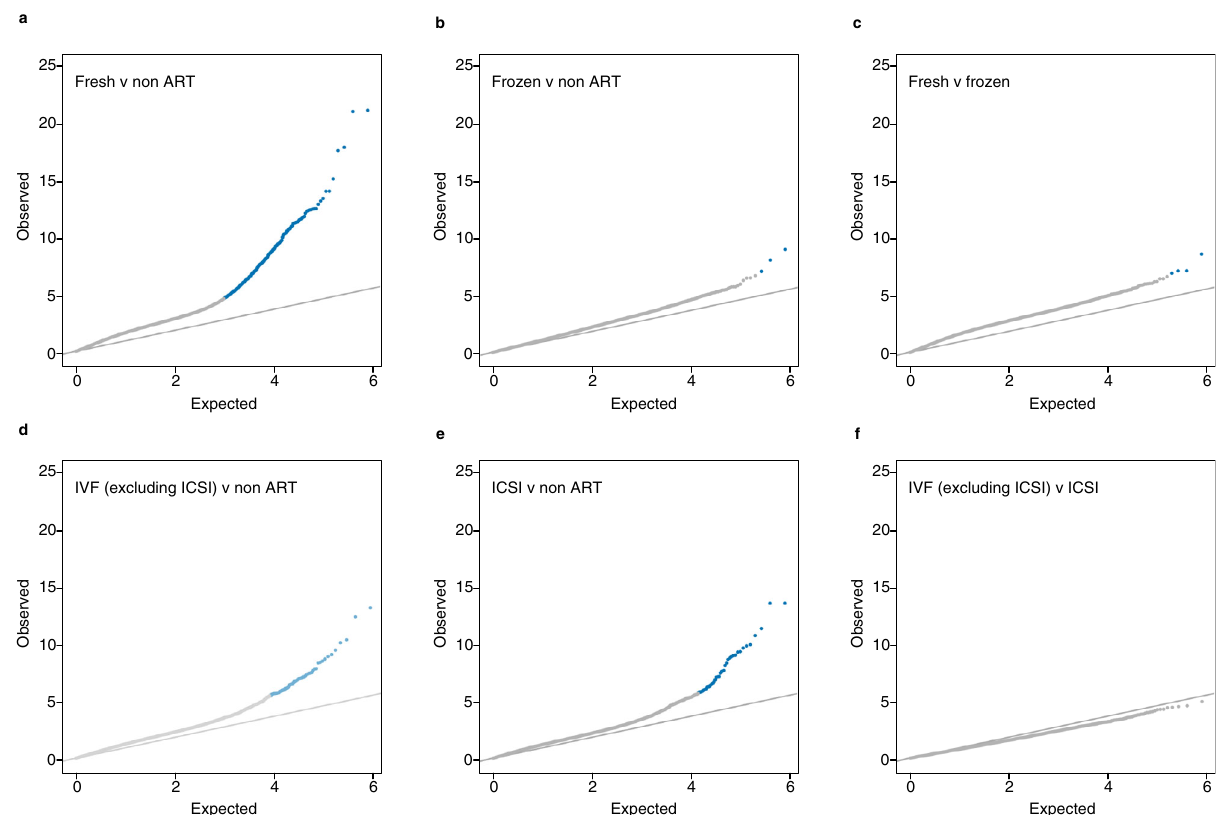
Fig. 5 Quantile-Quantile plots of observed versus expected − log 10 P values for methylation differences with different ART procedures. The observed − log P values on the y-axis (calculated from t statistics) were derived from two-sided t tests comparing the DNA methylation levels between: a ART 10 conceived newborns using fresh embryo transfer ( n = 764) and naturally conceived newborns ( n = 983), b ART conceived newborns using frozen embryo transfer ( n = 126) and naturally conceived newborns ( n = 983), c ART conceived newborns using frozen embryo transfer ( n = 126) and fresh embryo transfer ( n = 764), d ART conceived newborns using in vitro fertilization (IVF) without intracytoplasmic sperm injection (ICSI) ( n = 511) and naturally conceived newborns (n = 983), e ART conceived newborns using IVF with ICSI ( n = 359) and naturally conceived newborns ( n = 983), f ART conceived newborns using IVF with ICSI ( n = 359) and ART conceived newborns using IVF without ICSI ( n = 511). The adjusting variables were maternal age, maternal smoking, maternal body mass index, child sex, parity, and plate ID. Blue dots indicate signi fi cant CpGs at FDR < 0.01, while gray dots indicate nonsigni fi cant CpGs. The diagonal lines in the panels ( a – f) indicate the expected − log 10 P values if there were no difference between the groups. Source data are provided as a Source Data fi